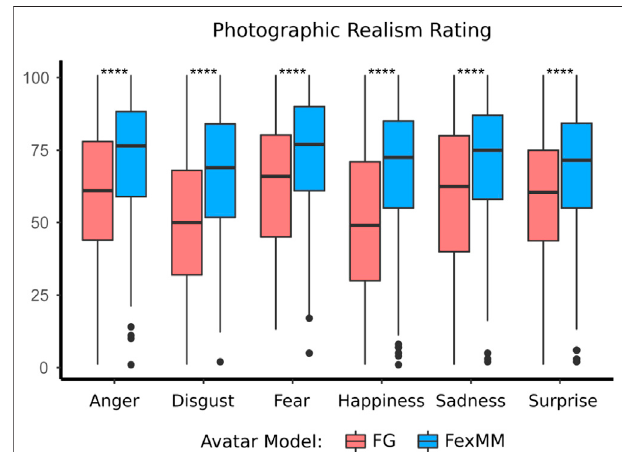
FIGURE 9 | Boxplot of photographic realism ratings comparing the two avatar types. Level of signi fi cance is indicated by **** ( p < 0 . 001 ) . The boxes denote the interquartile range and the median. Outliers are indicated as observations that lay outside 1.5 times the interquartile range of the interindividual distributions. The outliers were not eliminated for subsequent statistical